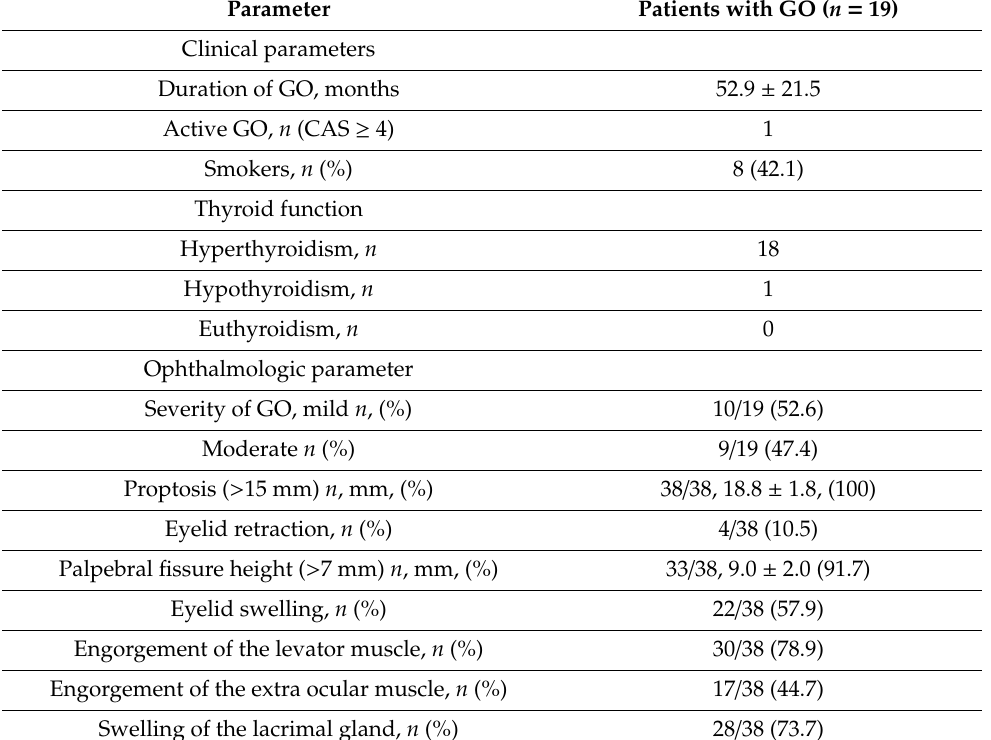
Table 1. Clinical characteristics and ophthalmologic parameter of the 19 patients with Graves’